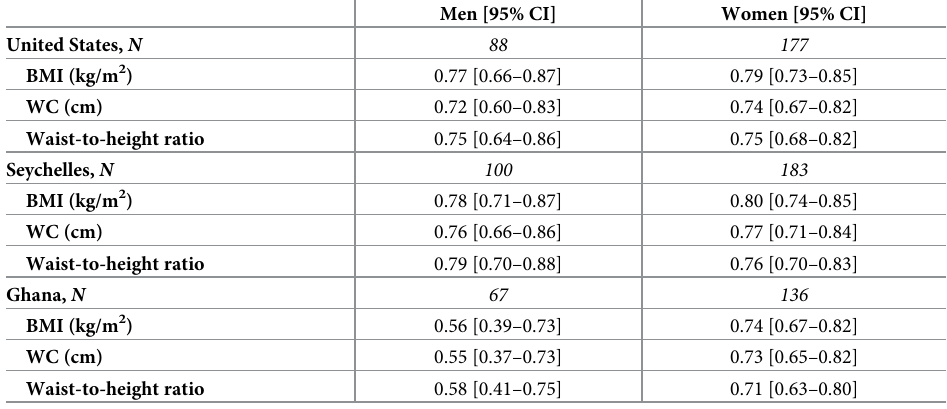
Table 2. Spearman correlation coefficients (r) between self-reported silhouette ranking and continuous anthropo- metric measures in men and women from the US, Seychelles, and